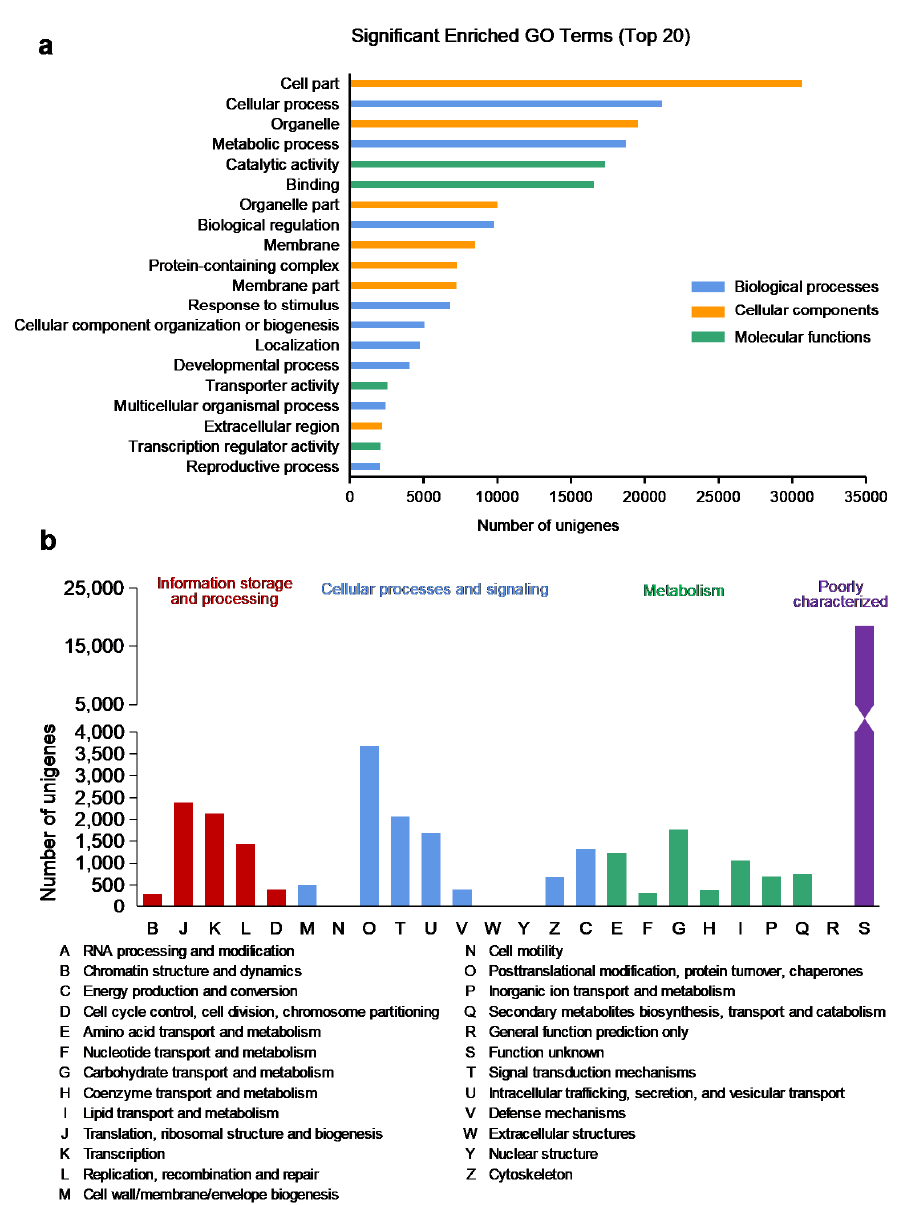
Figure 2. Functional annotation of unigenes identified in A. pusilla leaf transcriptome. ( a ) GO functional classification analysis; ( b ) EggNOG classification